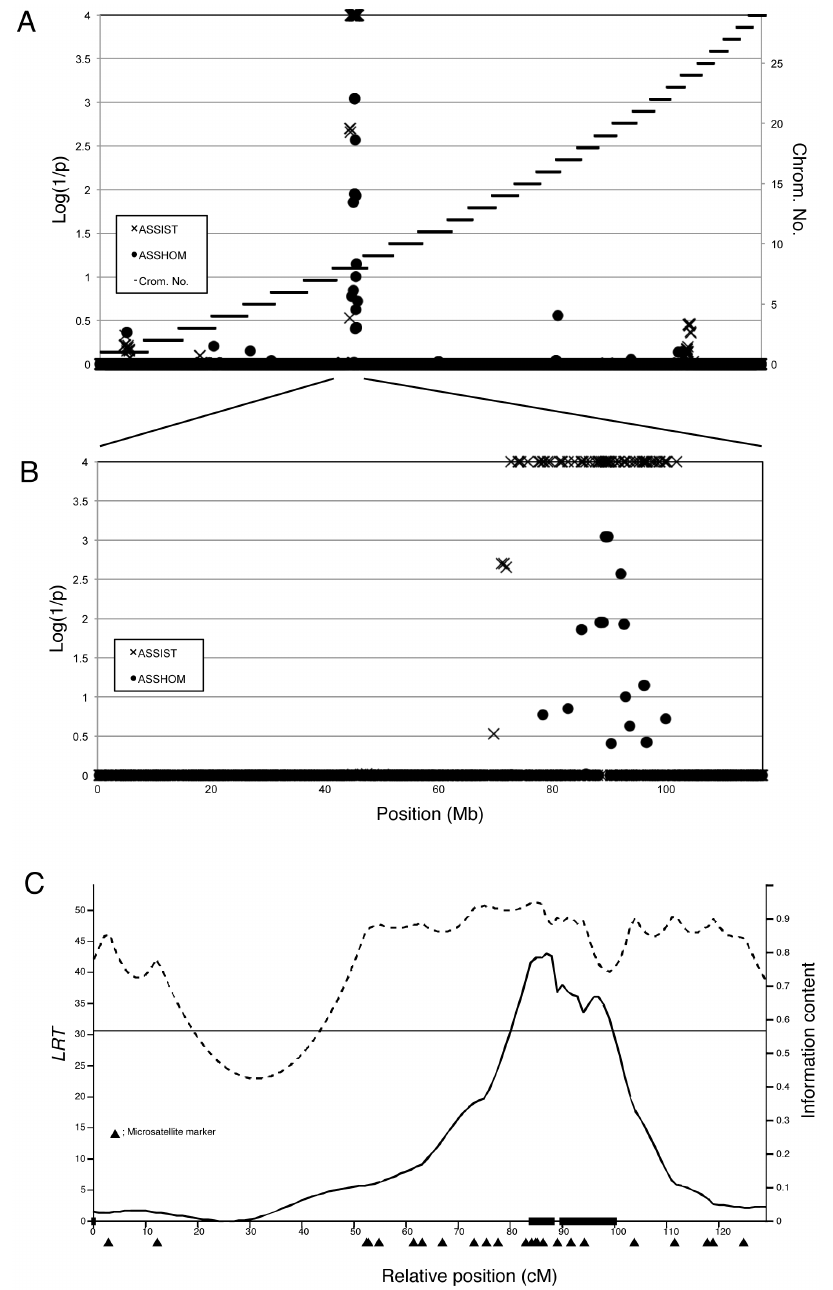
Figure 2. Genome-wide homozygosity mapping of perinatal weak calf syndrome. (A) The results of the genome-wide homozygosity N mapping of perinatal weak calf syndrome with a paternal half-sib family composed of 13 affected and 30 normal animals sired from Bull A using ) and ASSIST (X). The black horizontal bars mark the limits between the 29 autosomes. (B) The results of the homozygosity mapping on ASSHOM ( BTA 8. (C) The LRT -statistic profile for the disease on BTA 8. The horizontal line indicates the threshold for the 1% chromosome-wise significance level. The dashed line indicates information content (right y -axis). Microsatellite positions are indicated as filled triangles under the x -axis, respectively. The filled boxes on the x -axis represent the 95% confidence interval. The 95% confidence interval was flanked by IDVGA-52 (79.3 Mb) and MNB-38 (102.6 Mb), corresponding to the results of homozygosity mapping.